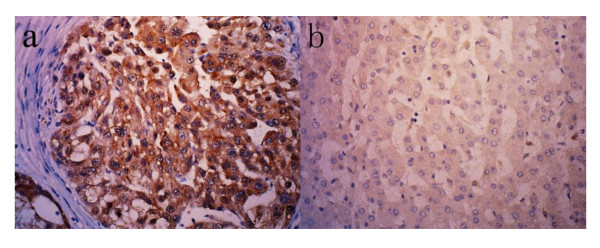
Representative immunohistochemical staining of HMGB1 in tumor and para-tumor tissue. (a) Over expression of HMGB1 in tumor tissue, HMGB1 immunostaining was predominantly located in cytoplasm of tumor cells (×400); (b) Low expression of HMGB1 in para-tumor tissue (×400).